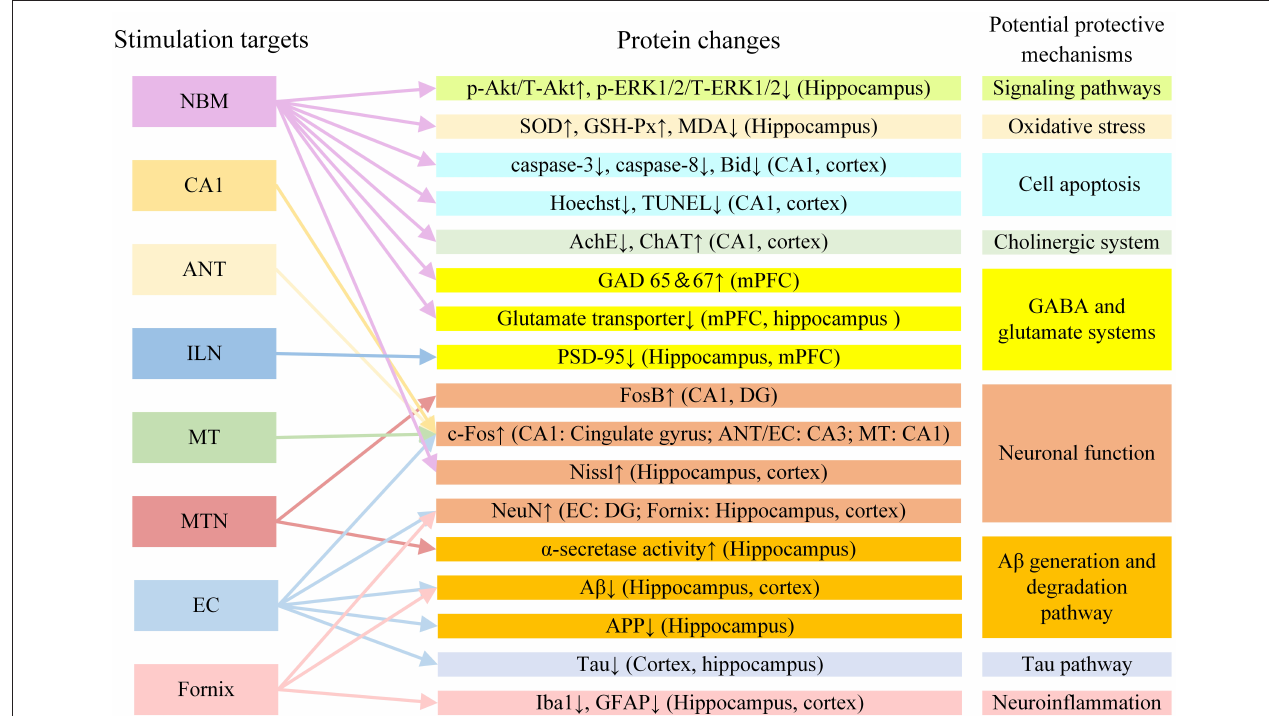
FIGURE 4 | The protein changes and potential protective mechanisms in AD animal models after DBS in the current study. A β , β -amyloid; AchE, acetylcholine esterase; ANT, anterior nucleus of thalamus; APP, amyloid precursor protein; ChAT, choline acetyltransferase; EC, entorhinal cortex; DG, dentate gyrus; GABA, gamma-aminobutyric acid; GAD 65 and 67, glutamate acid decarboxylase 65 and 67; GFAP, glial fibrillary acidic protein; GSH-Px, glutathione peroxidase; ILN, intralaminar thalamic nucleus; MDA, methane dicarboxylic aldehyde; mPFC, medial prefrontal cortex; MT, mammillothalamic tract; MTN, midline thalamic nuclei; NBM, nucleus basalis of Meynert; PSD-95: postsynaptic density protein 95; SOD, superoxide dismutase; VC/VS, ventral capsule/ventral striatum.